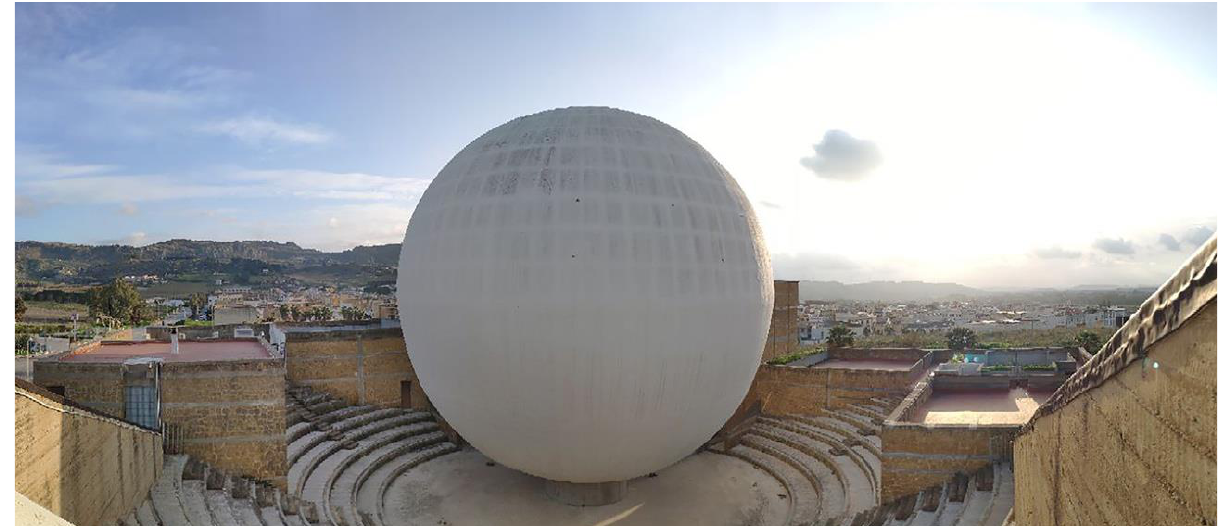
Figure 9. Chiesa Madre, Gibellina, project by Ludovico Quaroni (1970). Photo by the authors, Gibellina 2020.